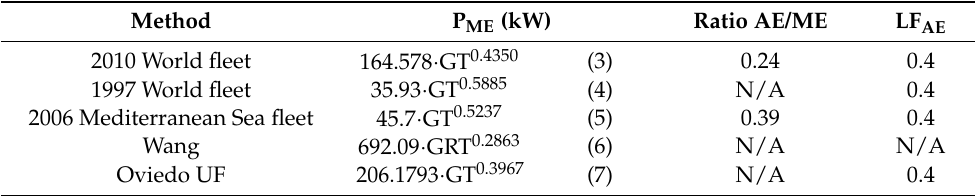
Table 2. Calculation methods for the auxiliary engine power for hoteling of Ro–Ro ships as a function of GT.